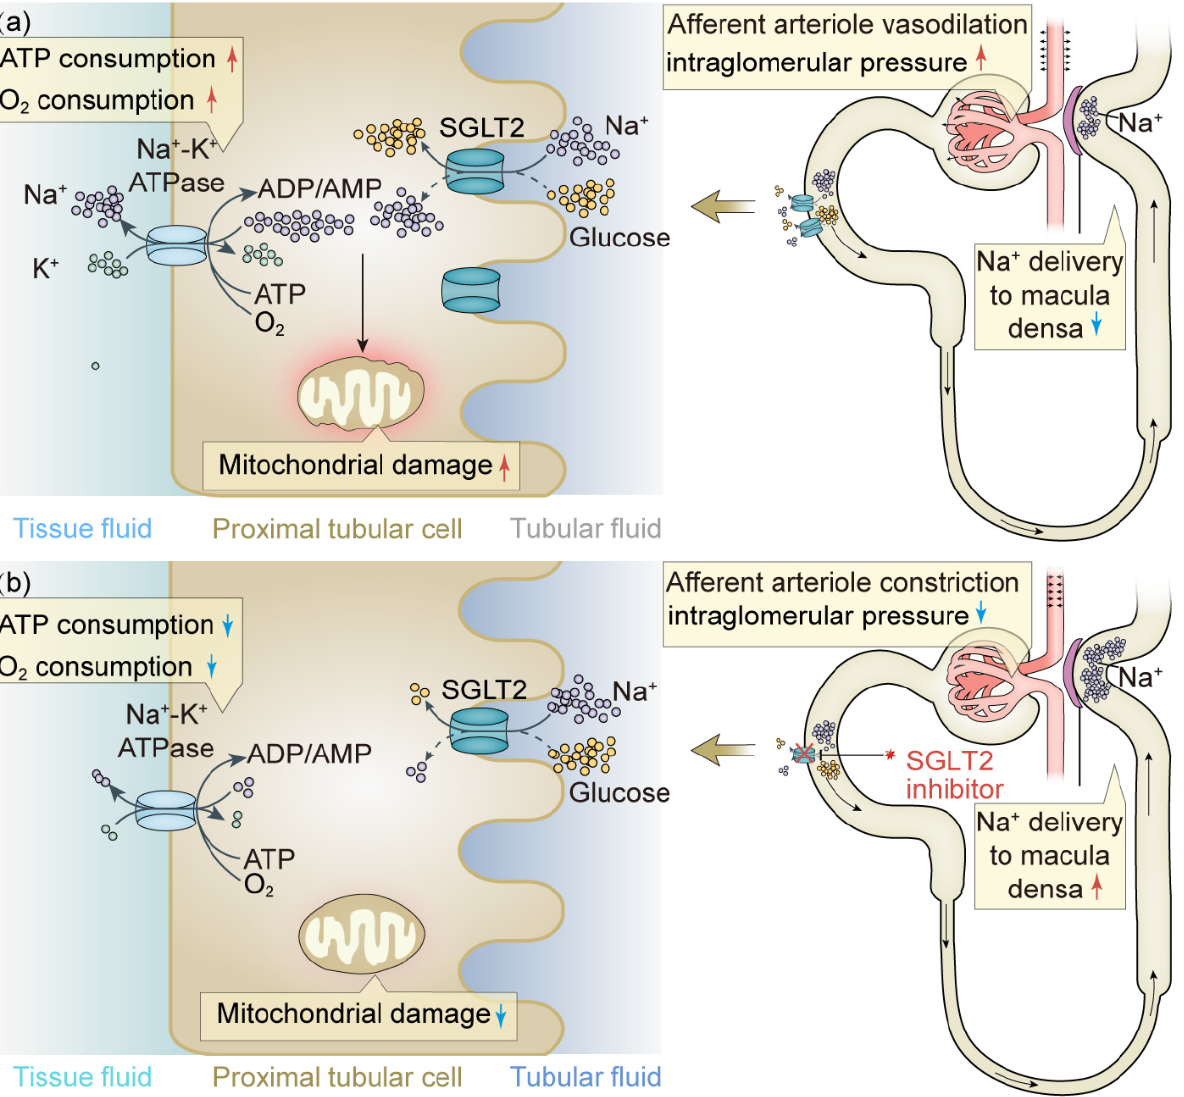
Figure 1. The renoprotective mechanisms of SGLT2 inhibitors. The molecular mechanisms of SGLT2 under hyperglycemia conditions with and without SGLT2 inhibitor. ( a ) SGLT2 is upregulated under hyperglycemic conditions. The reabsorption of sodium and glucose increased, which resulted in the activation of Na + -K + ATPase, thus leading to increased ATP and oxygen consumption and mitochondrial damage. The increased resorption of sodium resulted in the low sodium concentration in the macula densa and activated tubuloglomerular feedback, causing the vasodilation of afferent arterioles and increased intraglomerular pressure. ( b ) SGLT2 inhibitors reversed the above changes through inhibiting the resorption of sodium and glucose and increasing the sodium concentration in the macula densa, leading to afferent arteriole constriction and reduced intraglomerular pressure. SGLT2, sodium-dependent glucose transporters 2; ATP, adenosine triphosphate; ADP adenosine diphosphate; AMP, adenosine monophosphate; Na + -K + ATPase: sodium-potassium ATPase. Upper arrow in red indicates increase; down arrow in blue indicates decrease.